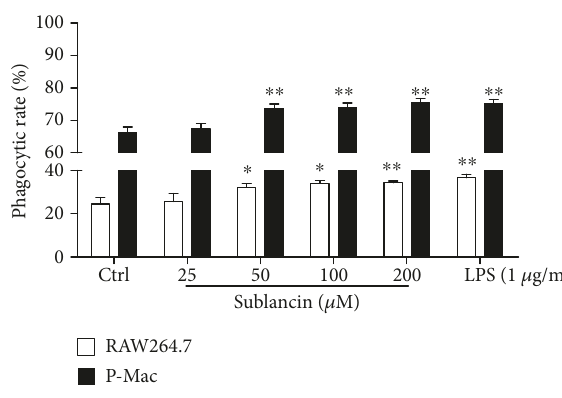
Figure 1: E ff ect of sublancin on phagocytic activity of RAW264.7 cells and mouse peritoneal macrophages (P-Mac) in vitro. RAW264.7 cells and P-Mac were treated with sublancin (0- 200 μ M) or LPS (1 μ g/ml) for 12h. Phagocytic activity of macrophage cells was assessed in terms of the population of phagocytic cells relative to the total number of cells for RAW264.7 cells and P-Mac. The values are presented as mean ± SEM ( n = 6 ). Signi fi cant di ff erences with control cells were designated as ∗ P < 0 05 or ∗∗ P < 0 01